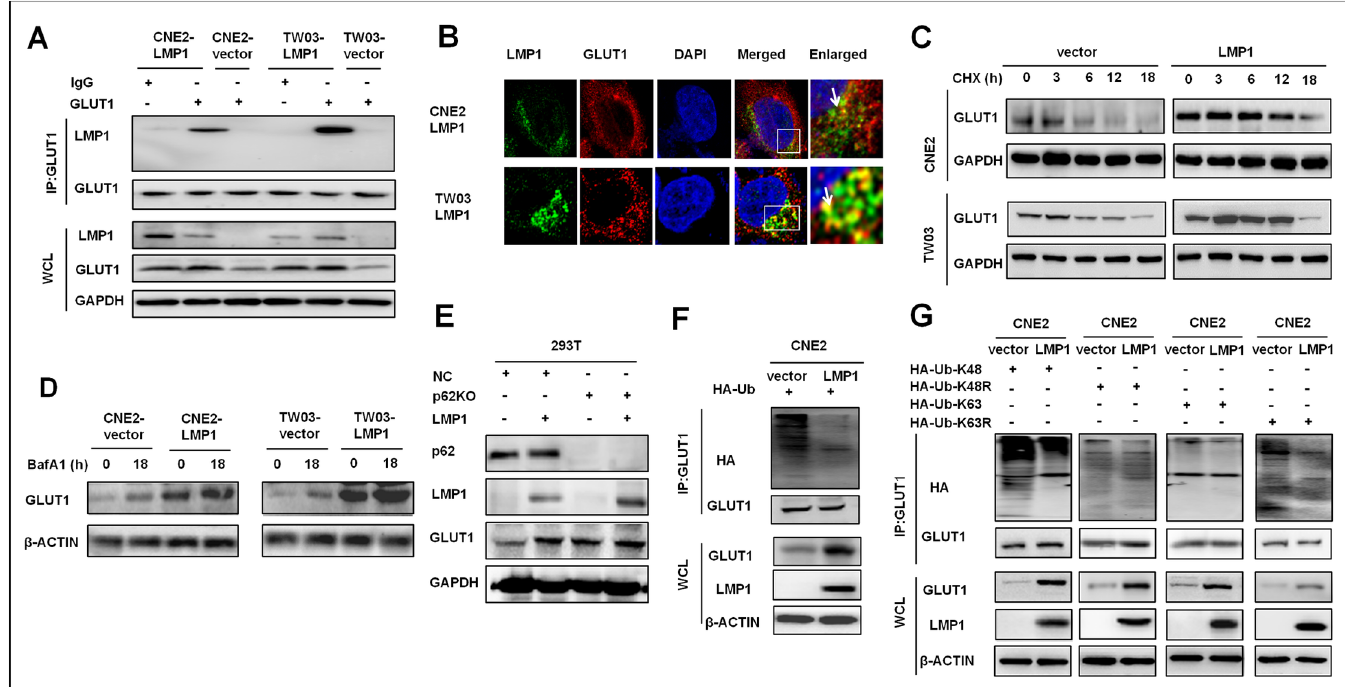
Fig 6. LMP1 co-expression with GLUT1 in NPC-LMP1 cells stabilized GLUT1 proteins by disrupting GLUT1 K48ubiquitination and p62-dependent lysosomal degradation. ( A )LMP1physicallyinteractswithendogenous GLUT1.NPC-LMP1andNPC-vectorcellsweretreatedwithMG-132(1 μ M)for 4 h to stabilizeGLUT1,followedbyimmunoprecipitation(IP) withananti-GLUT1 antibody.Immunoblotting wasperformed usinganti-LMP1andanti-GLUT1 antibodies. Anti-IgGwasusedas a negativecontrolfor IP. Representativedatafrom 5 independent experiments areshown.( B )Immunofluorescencedetectionof EBV-LMP1 andGLUT1instableNPC-LMP1celllines.NPC-LMP1andNPC-vectorcellswereseededontoa chamberedcoverglassovernight.LMP1andGLUT1 were detectedwithLMP1andGLUT1 antibodies, nucleiwerestainedwithDAPI, andconfocalimageswereanalyzedusingImageJsoftware.( C )NPC-LMP1andNPC- vectorcelllinesweretreatedwithCHXfor 18h. Proteinswereharvestat 0, 3, 6, 12 and18 h, andthe expression of GLUT1wasmeasuredvia immunoblotting. Representativedatafrom 5 independent experiments areshown,andGAPDHwasincludedas a control.( D )NPC-LMP1andNPC-vectorcelllinesweretreated withthelysosomeinhibitor BafA1for 12h, proteinswereharvestedat 0 and12h, andGLUT1 expression wasmeasured byimmunoblotting. Representativedata from 5 independent experiments areshown,andGAPDHwasincludedas a control.( E )Immunoblottingshowedthat GLUT1 wasexpressedat higherlevelsin 293Tcellsthaninp62KO-293T cells,whereasGLUT1wasexpressedat higherlevelsin 293T-LMP1 cellsthanin293Tcellsbutwasnot foundat higherlevelsin p62KO-293T-LMP1cellscomparedwithp62KO-293T cells.Representativedatafrom 1 of 5 experiments areshown.( F-G ).NPC-LMP1andNPC-vector celllines culturedin 6-wellplatesweretransfected withhemagglutinin(HA)-taggedUb(4 μ g/well) ( F )HA-tagged Ub-K48,HA-taggedUb-K48R,HA-tagged Ub-K63or HA-tagged Ub-K63R( G )andthentreatedwith20mM MG132for 6 h priorto harvest.Celllysateswereimmunoprecipitatedwithanti-HAantibodiesandthen subjectedto WB withananti-GLUT1antibodyto measurethe levelsof ubiquitinated GLUT1proteins(upperpanels).WCLswereblottedto evaluate thelevelsof GLUT1proteins(lowerpanels). β -actinexpressionwasusedas a proteinloadingcontrol.The experiment shownis a representativeof threeindependent